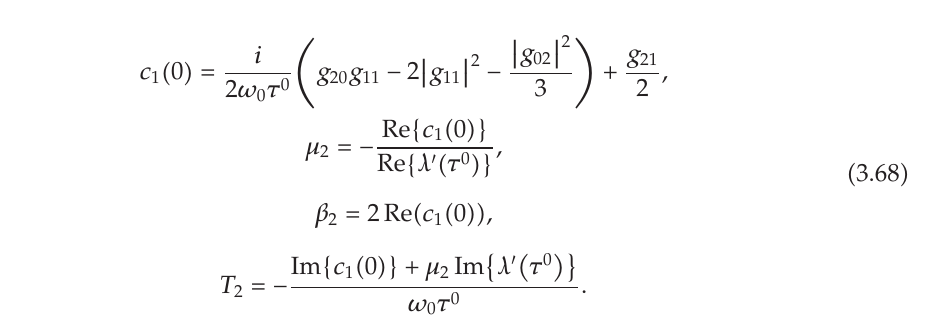
Figure 1: Trajectories graphs of the system (cid:2) 4.1 (cid:3) with τ 1 (cid:6) 0 . 003 ,τ 2 (cid:6) 0 . 004, and τ 1 (cid:7) τ 2 (cid:6) 0 . 007 < τ 0 ≈ 0 . 01. The equilibrium E ∗ (cid:2) 0 , 0 (cid:3) is asymptotically stable. The initial value is (cid:2) 0.05, 0.01 (cid:3) . From (cid:2) 3.48 (cid:3) , (cid:2) 3.50 (cid:3) , we can calculate g 21 and derive the following